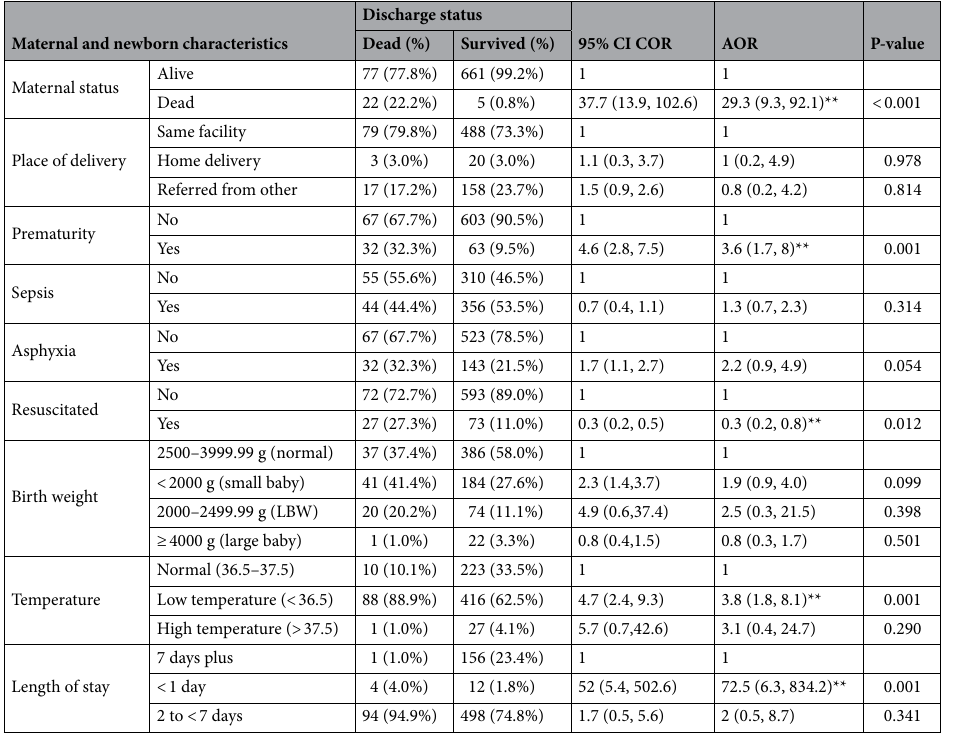
Table 4. Multivariable logistic regression analysis of maternal and newborn characteristics by early neonatal mortality, NICU of Referral hospital from May 2019 to May 2021. *Significant at P-value < 0.05 **Significant at P-value <